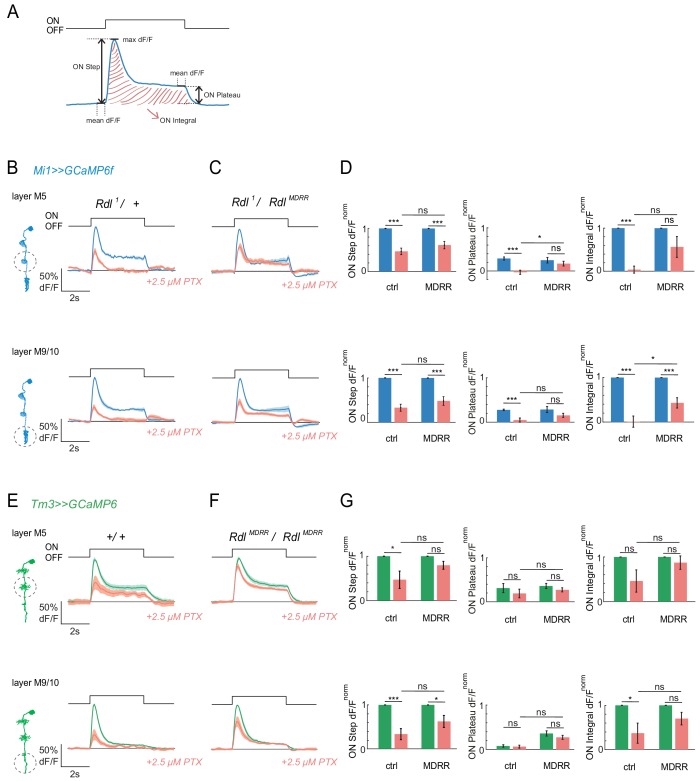
Pharmacogenetics shows that ON responses are partially mediated by the GABAAR Rdl.(A) Schematics showing the quantification of the step response, the plateau response and the integrated response. (B,C) In vivo calcium signals in response to full-field stimulation recorded in layers M5 and M9/10 of Mi1 neurons. Figure shows traces before (blue) and after (red) application of 2.5 µM PTX in heterozygous Rdl1/+ controls (A, n = 7[55]/[78]), or flies only expressing the PTX-insensitive RdlMDRR allele (Rdl1/RdlMDRR) (B, n = 8[76]/[90]). (D) Bar plots showing the quantification of the data from (A, B). (E,F) In vivo calcium signals in response to full-field flashes recorded in the layers M5 and M9/10 of Tm3 neurons. Figure shows traces before (green) and after (red) PTX application in wild type (+/+) (D, n = 5[36]/[47]), or flies only expressing the PTX-insensitive RdlMDRR allele (RdlMDRR/RdlMDRR) (E, n = 5[57]/[57]). (G) Bar plots showing the quantification of data from (D,E). All traces show mean ± SEM. Sample sizes are given as number of flies [number of cells in M5/M9/10], *p<0.05, ***p<0.001, tested with an unbalanced two-way ANOVA, corrected for multiple comparisons.10.7554/eLife.49373.016Figure 4—figure supplement 1—source data 1.Table 1 contains all mean ± s.e.m.Data related to quantifications shown in main Figure 4—figure supplement 1, sorted by genotype and experimental condition.